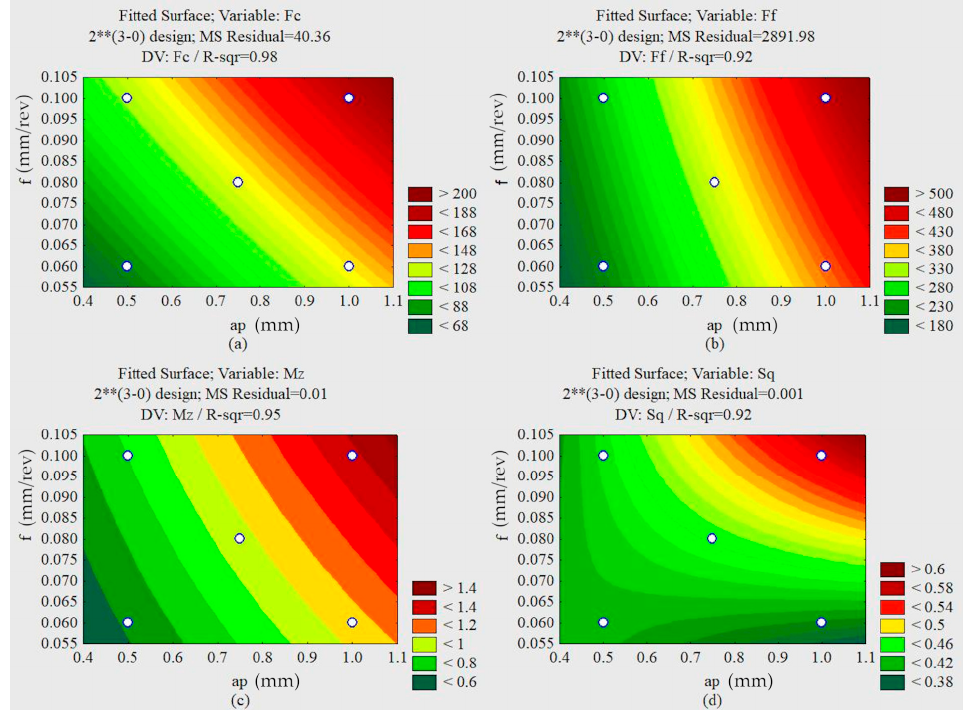
Figure 17. Response surfaces for the lubrication condition with graphite. ( a ) Cutting force F c (a p × f). ( b ) Feed force F f (a p × f). ( c ) Torque M z (a p × f). ( d ) Roughness S q (a p × f).